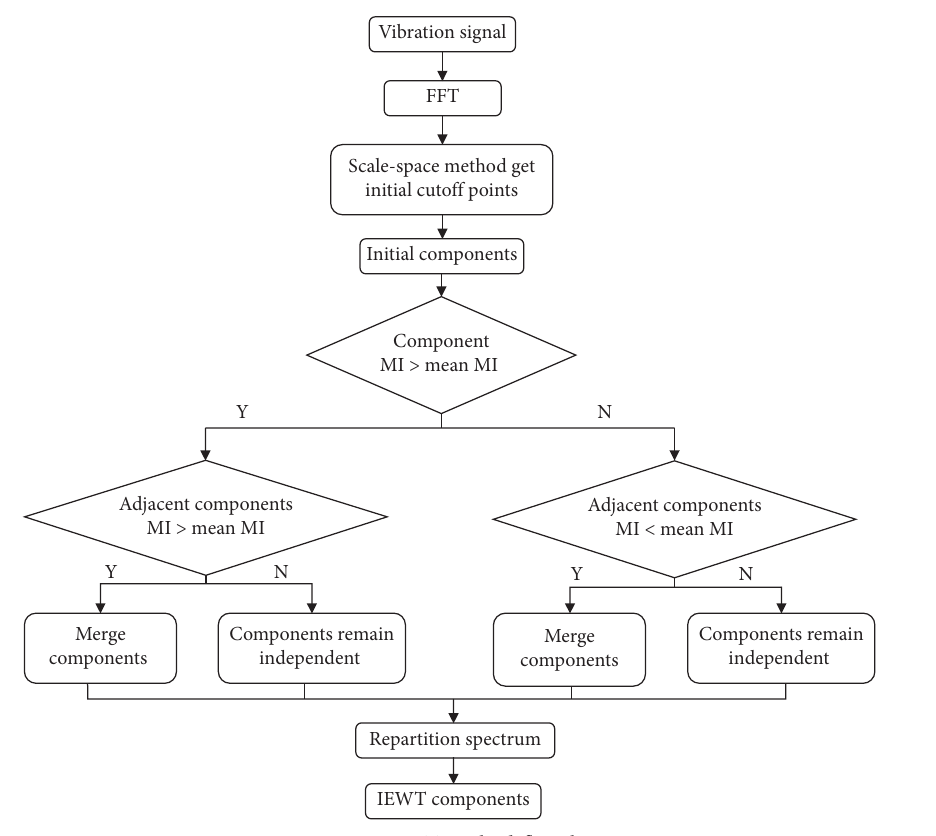
Figure 1: IEWT method flowchart.